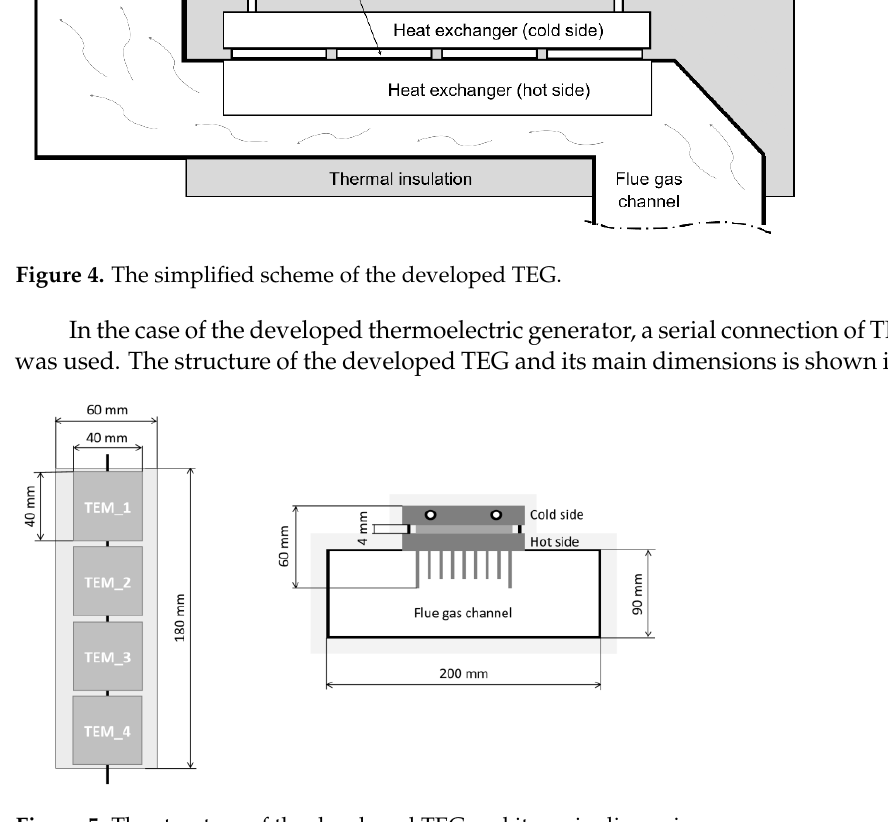
Figure 6. Comparison between the temperature of the flue gas measured during the experiment, the regression curve, and the numerical output.